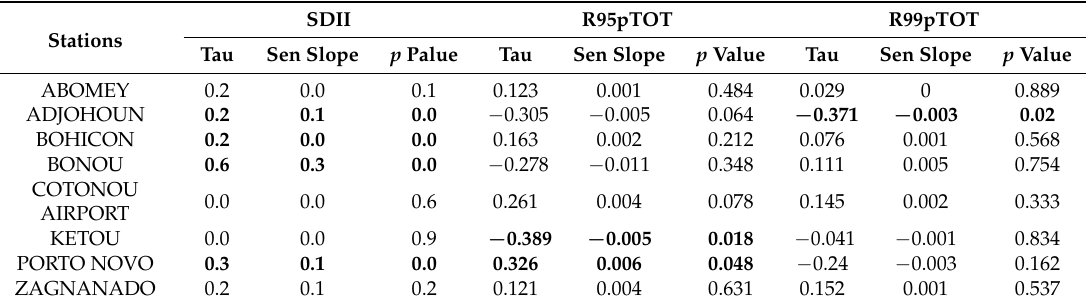
Table 4. Significant trend results of annual rainfall frequency indices.